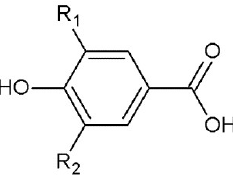
Figure 3. The structure of benzoic acid derivatives (R 1 =R 2 =H—hydroxybenzoic acid; R 1 =OH, R 2 =H—protocatechuic acid; R 1 =OCH 3 , R 2 =H—vanillic acid; R 1 =R 2 =OH—gallic acid; R 1 =R 2 =OCH 3 —syringic acid).